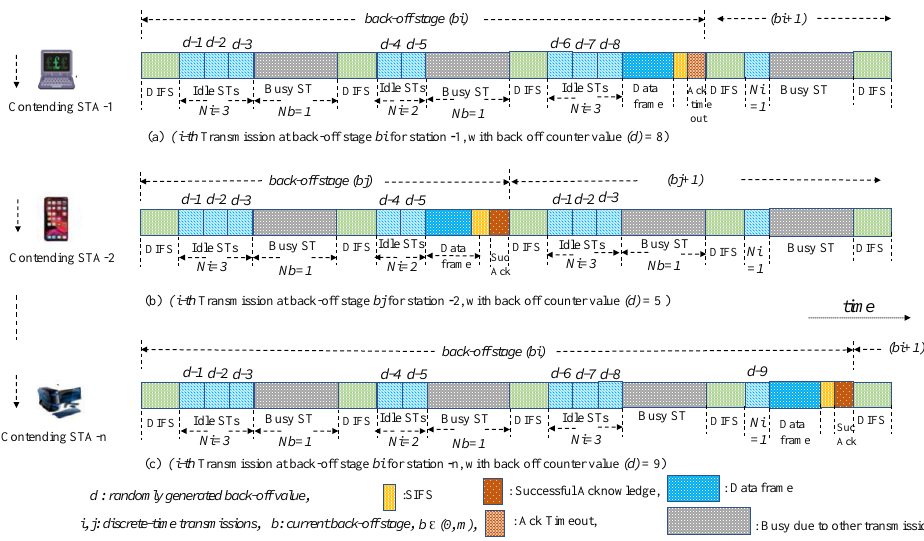
Figure 3. CWSB mechanism during the back-off